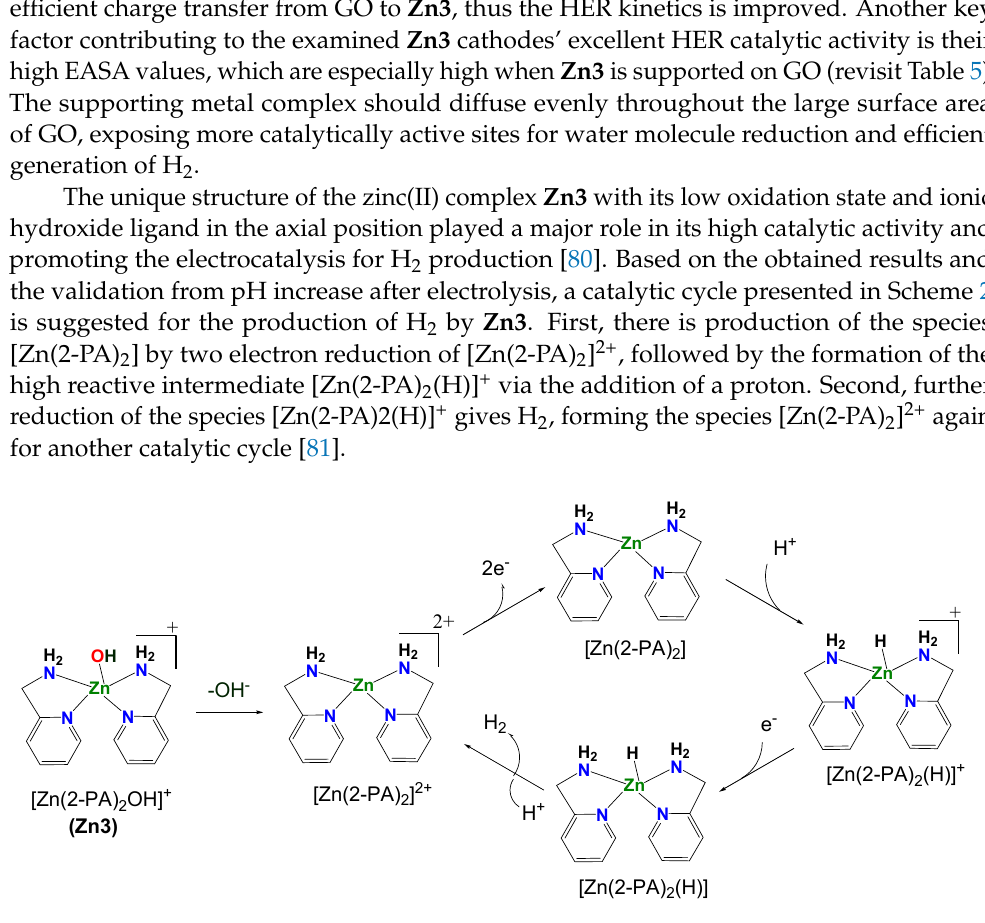
Figure 13. Long ‐ term stability test recorded for the best performing electrocatalyst, namely GC − MnC (0.8 mg cm − 2 ) in 0.1 M KOH solution at room temperature for the HER. LSV measurements were conducted at a scan rate of 50 mV s − 1 . Inset—chronoamperometry measurements performed on the catalyst at a constant applied potential of − 0.4 V vs. RHE. The catalyst displayed the outstanding stability in these solutions, as evidenced by the apparent low loss of current. Moreover, the Tafel slope remained almost constant (121 mV dec − 1 ) after the last loop, indicating that the HER mechanism is unaffected by the cat ‐ alyst’s cycling. More evidence for catalyst stability can be seen in the chronoamperometry measurements (inset of Figure 13) where the current remains constant throughout the op ‐ eration. 4. Conclusions A series of zinc(II) complexes, namely [PA) 2 ZnCl] 2 (ZnCl 4 )]